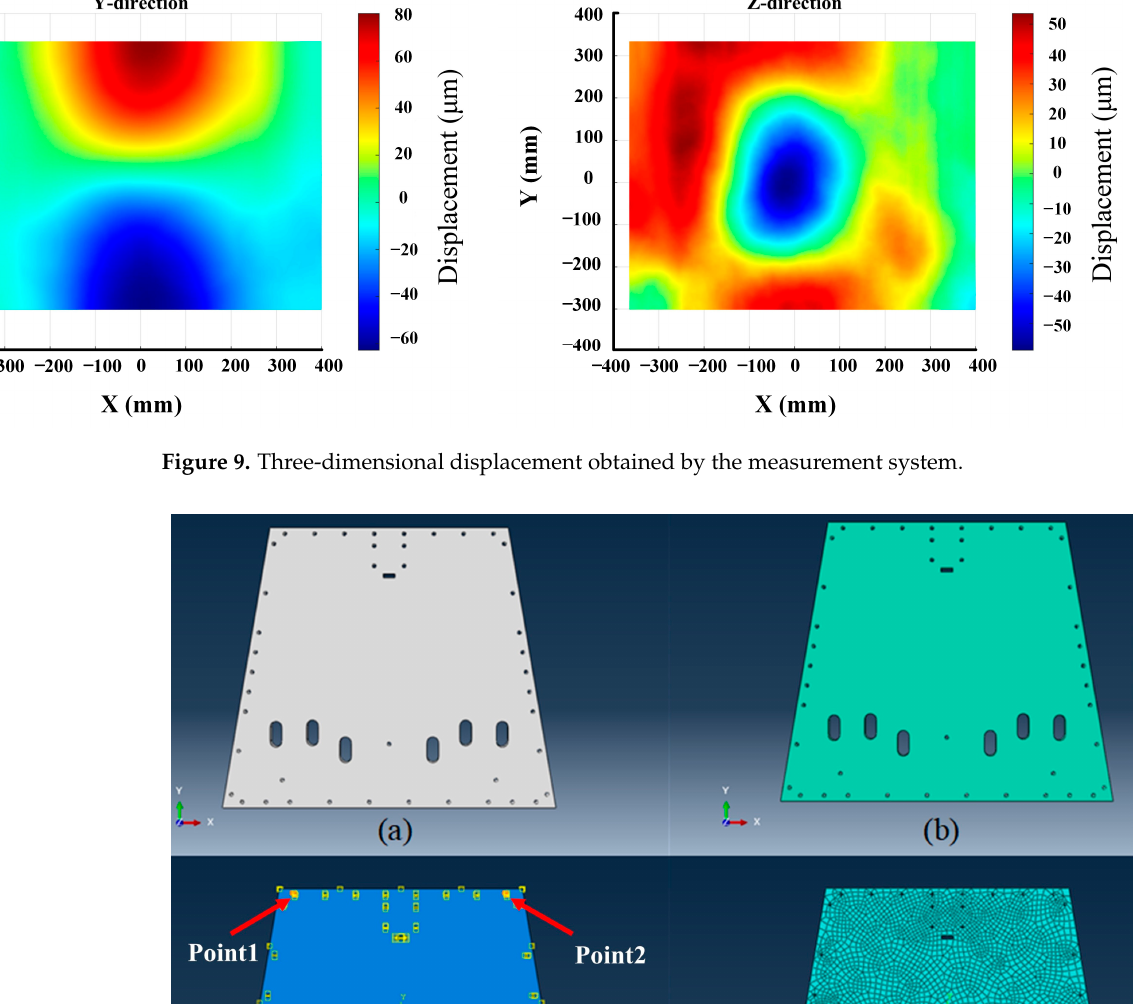
Figure 9. Three-dimensional displacement obtained by the measurement system.